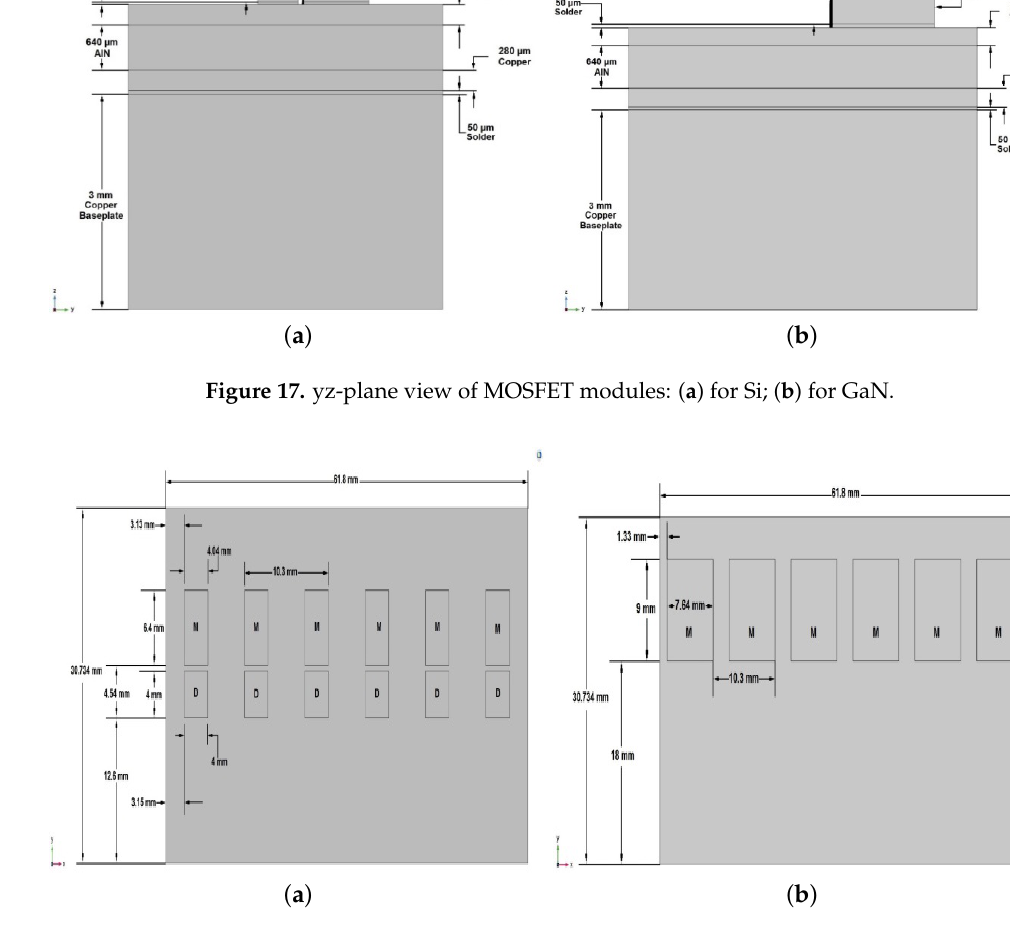
Figure 18. xy-plane view of MOSFET modules: ( a ) for Si; ( b ) for